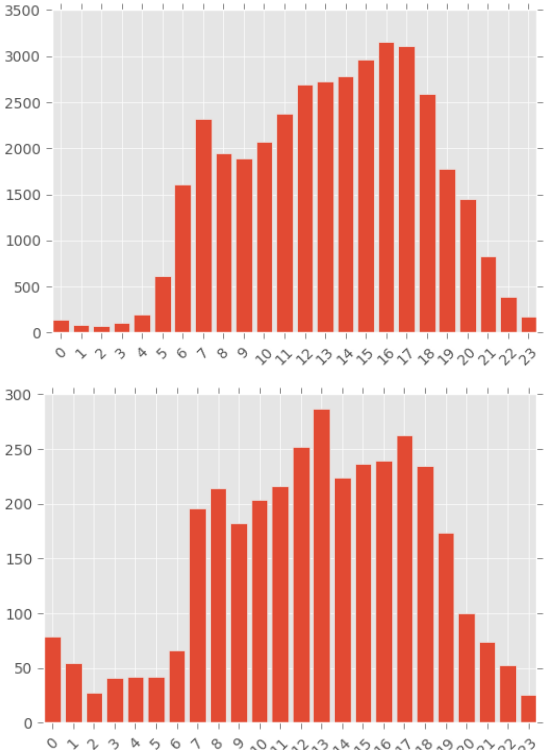
Figure 6 . Number of travels in each hour of day based on survey data (top) and geo-tweets (bottom)